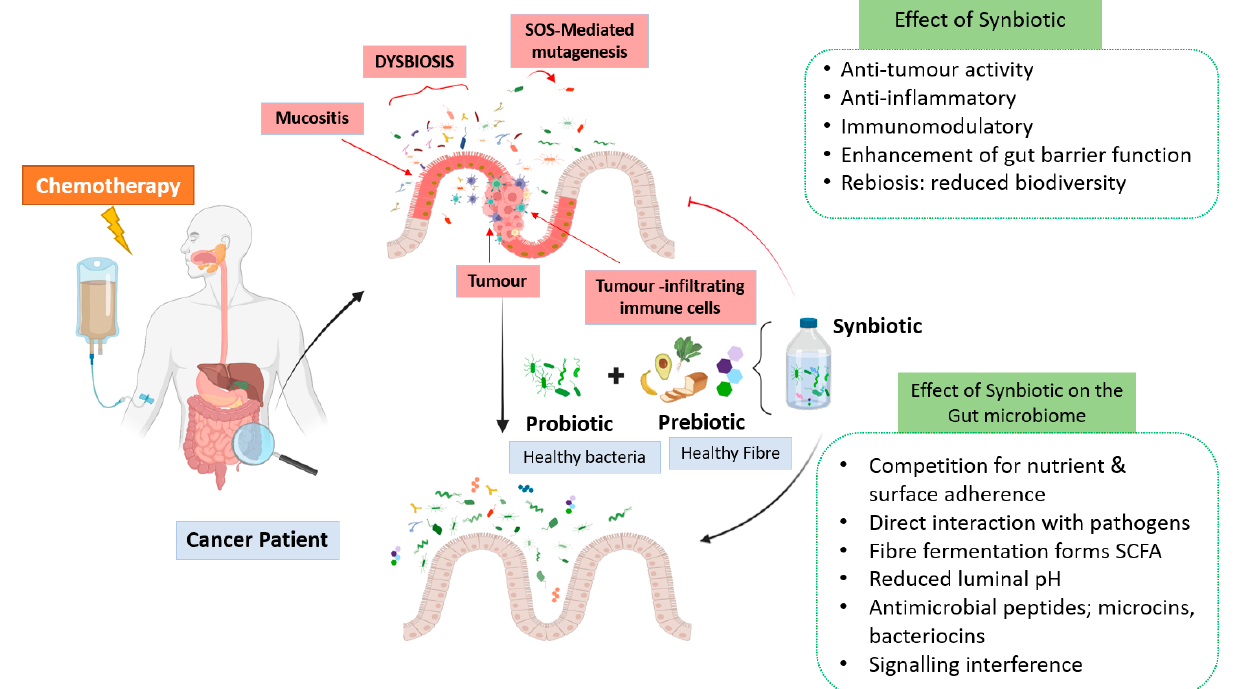
Figure 1. Cancer and chemotherapy may deplete gut microbiota and thus lead to a development of mucositis and the dysbiotic condition. Synbiotic administration may help to restore the dysbiotic gut microbiota that were lost due to cancer and chemotherapy. A schematic representation of an unhealthy gut due to cancer and chemotherapy (on top ) and a healthy restored gut microbiota (in bottom ) after synbiotic administration during chemotherapy is shown.